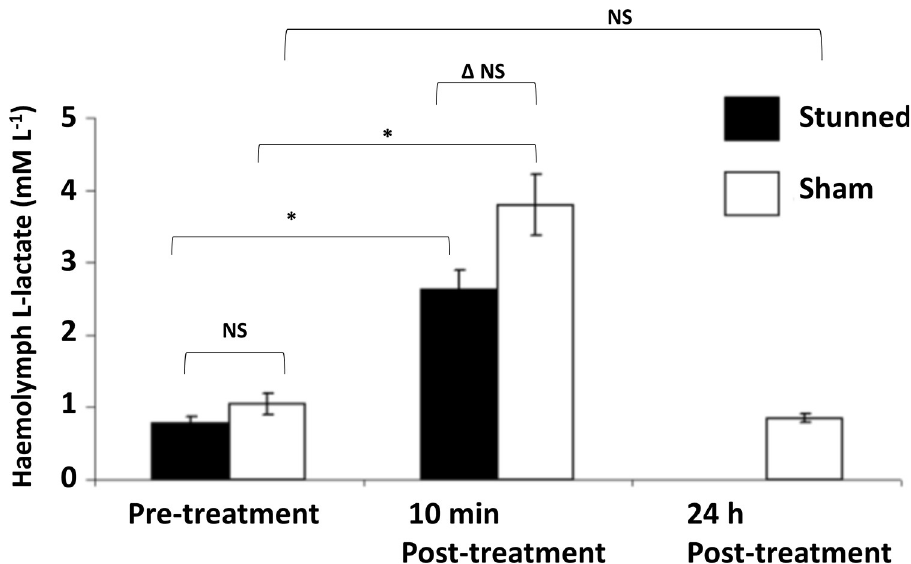
Fig 9. Measures of physiological stress before and after electrical stunning. Haemolymph L-lactate concentrations in C . pagurus before and after electrical stunning (black bars) or a sham-treatment (white bars). Mean values ± SEM. N = 6 for each treatment group. ( � ) indicates that values are significantly different (p < 0.05), (NS) indicates values are not significantly different, ( Δ ) indicates the difference/increase following the two treatments considering the changes in the values for individual crabs; (t-test p <